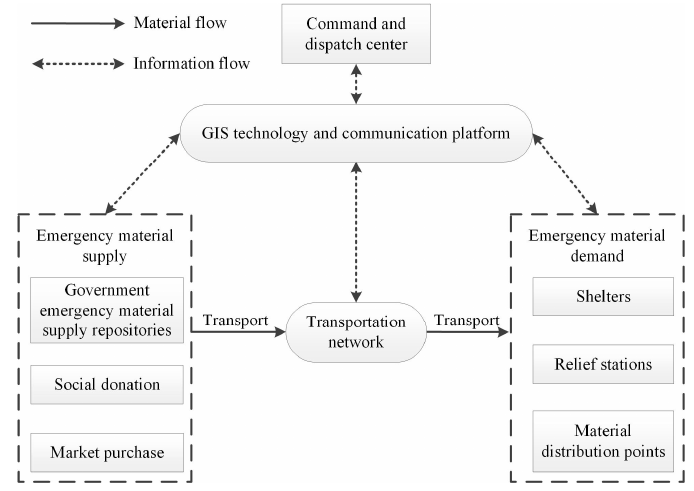
Figure 1 . The flow chart of emergency material vehicle dispatching and routing Figure 1. The flow chart of emergency material vehicle dispatching and routing